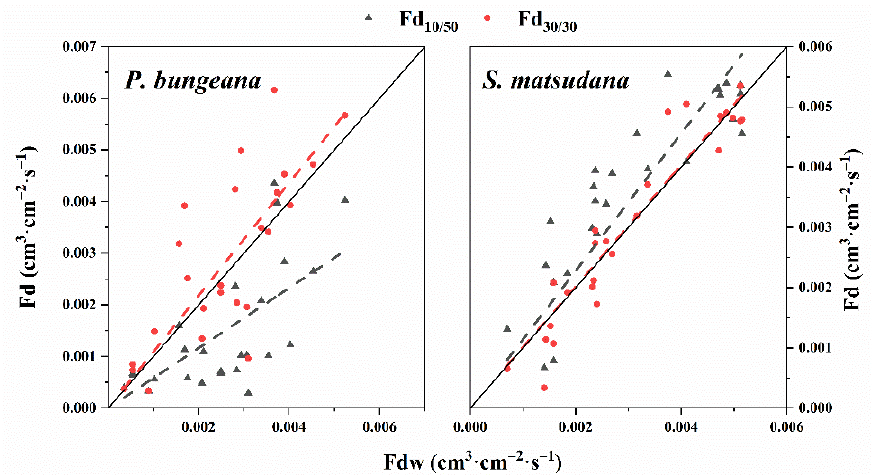
Figure 5. Verification of the accuracy of the calibration equations. The dashed black line represents the 10 min heating and 50 min cooling mode, the dashed red line represents the 30 min heating and 30 min cooling mode, and the solid black line is the 1:1 line.